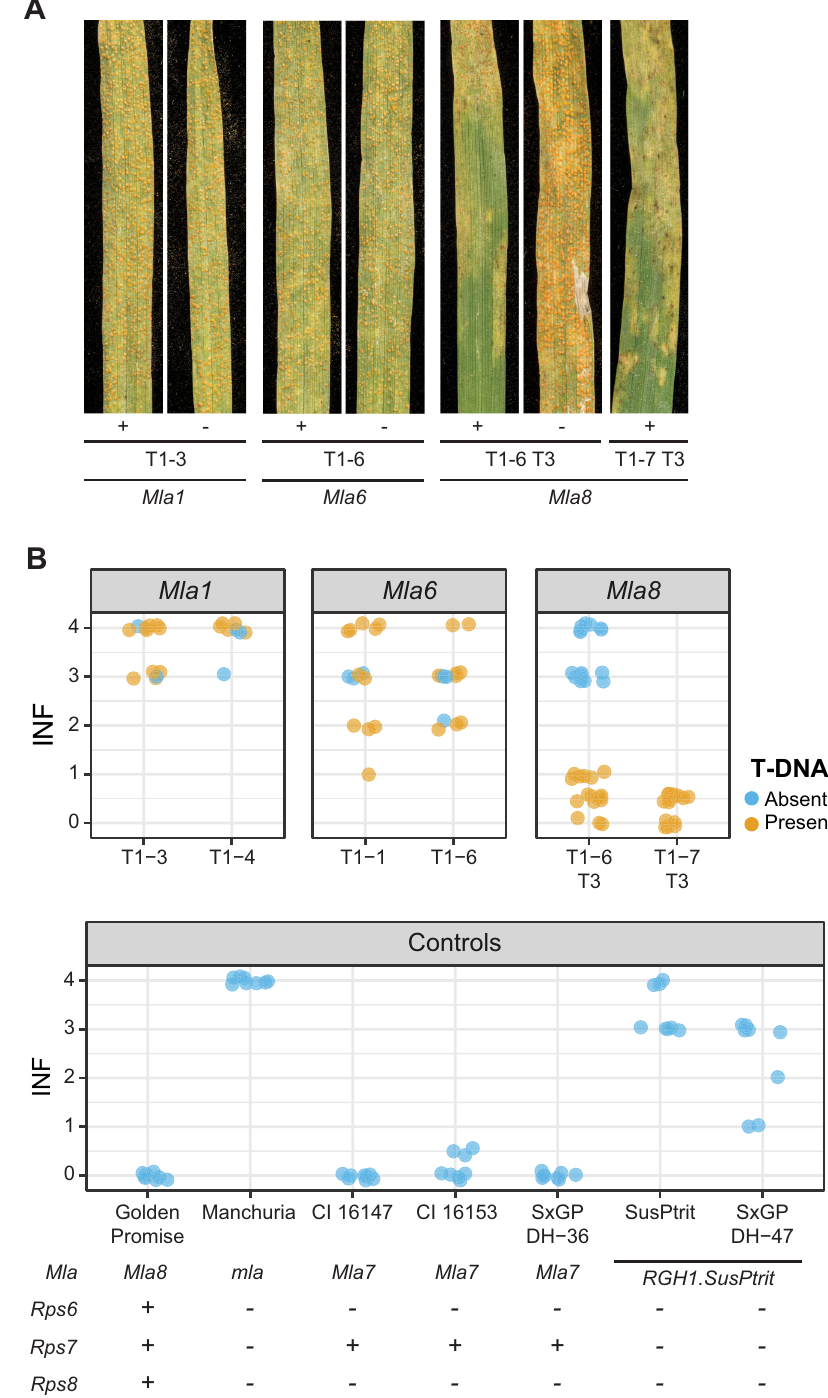
Fig. 5 Allele-speci fi c resistance of Mla to wheat stripe rust ( P . striiformis f. sp. tritici ) isolate 16/035. Wheat stripe rust susceptible barley cv. SxGP DH- 47 was transformed with Mla1 , Mla6 , and Mla8 driven by the Mla6 promoter and Mla6 terminator. Two single-copy insert lines were identi fi ed for Mla1 (T1- 3 and T1-4) and Mla6 (T1-1 and T1-6). For Mla8 , T 3 homozygous progeny present (T1-6 and T1-7) and absent (T1-6) for the transgene were used. Resistance to wheat stripe rust isolate 16/035 was observed in transgenic barley lines with single copy of Mla8 and in the controls Golden Promise ( Rps6 ; Mla8 / Rps7 ; Rps8 ), CI 16147 ( Mla7 / Rps7 ), CI 16153 ( Mla7 / Rps7 ), and SxGP DH-36 ( Mla8 / Rps7 ). Susceptibility to P . striiformis f. sp. tritici isolate 16/035 was observed in transgenic barley lines with T-DNA containing Mla1 and Mla6 . A Representative leaf phenotypes in the presence ( + ) or absence ( − ) of T-DNA for individual Mla alleles. B Infection phenotypes for individual leaves in T 1 families and controls. Presence or absence of T-DNA is shown in orange and blue, respectively. All phenotypes are on a scale from 0.0 to 4.0 in 0.5 increments represent the degree of leaf area covered with pustules. Transparency and jittering were used to visualize multiple overlapping data points. An extended set of controls for P. striiformis f. sp. tritici isolate 16/035 can be found in Supplementary Fig. 5 and 6. Source data are provided as a Source Data fi